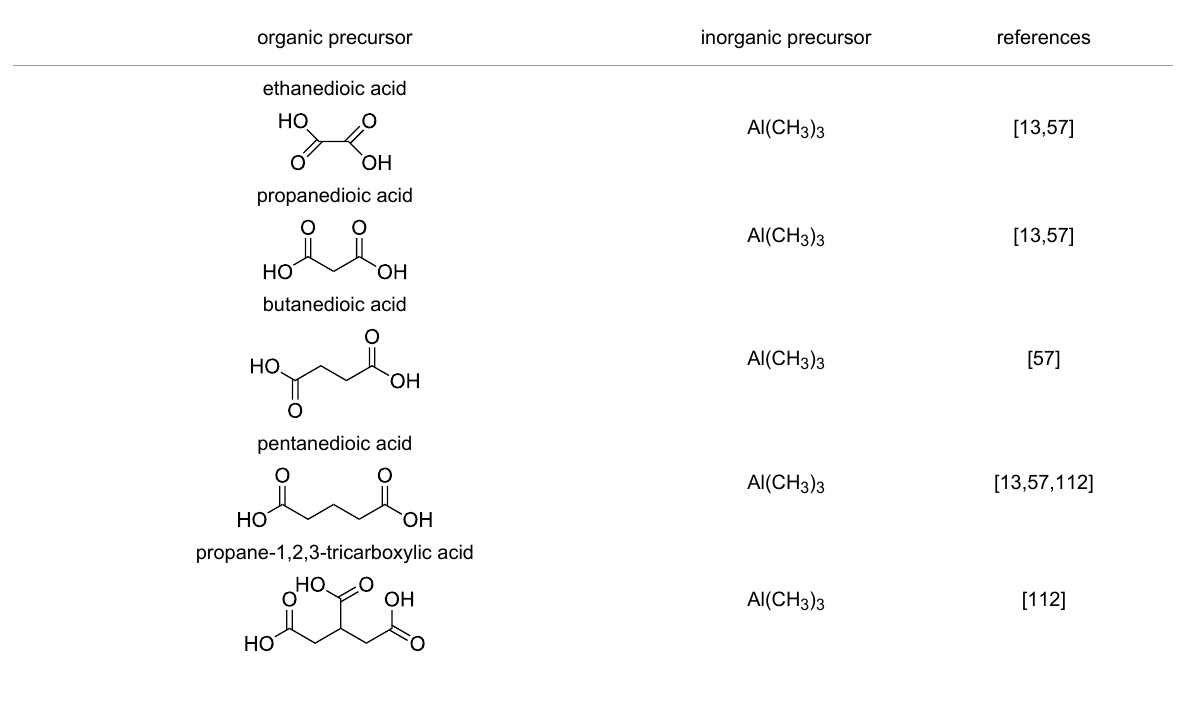
Table 12: Carboxylic acid precursors used to deposit inorganic–organic hybrid thin